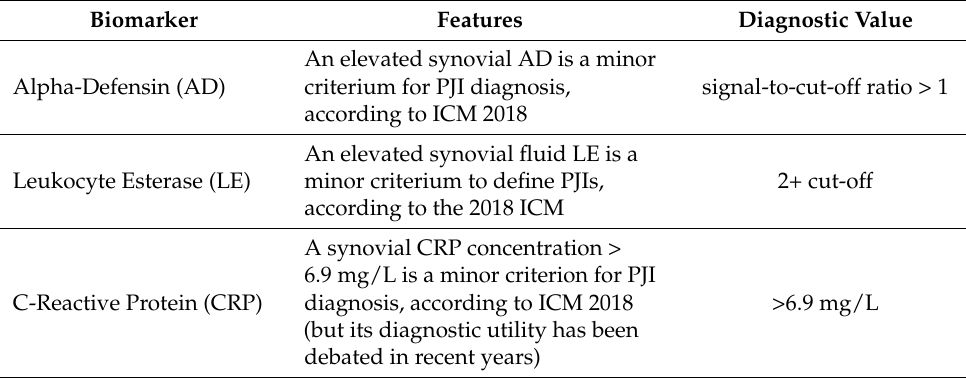
Table 3. Synovial biomarkers